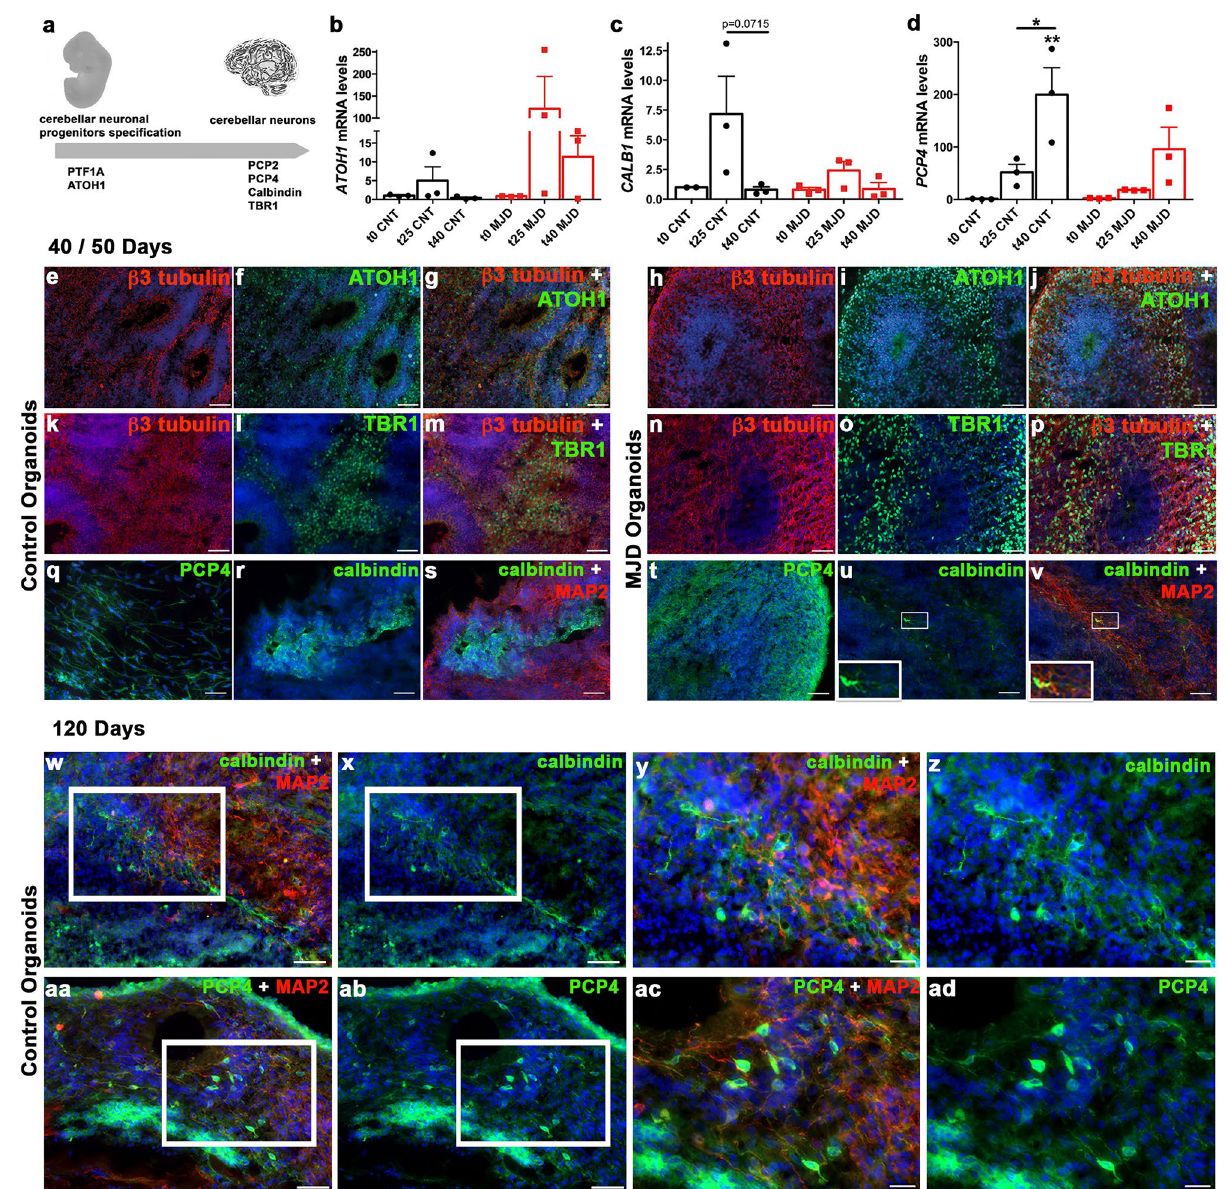
Figure 3. Control and MJD brain organoids present markers of cerebellar neurons. (a) Schematic representation of cerebellar neuronal progenitors (PTF1a and ATOH1) and cerebellar neurons (PCP2, PCP4, Calbindin, and TBR1) markers expression in cerebellum development. (b) ATOH1 , (c) CALB1 , and (d) PCP4 mRNA levels evaluation of Control (CNT) and MJD organoids, normalized for t0 CNT, collected at different time points (day 0, 25, and 40; t0, t25, and t40 respectively). Data indicated a significant enhancement of PCP4 mRNA levels at day 40. Data are expressed as mean ± SEM (n: 3 independent experiments), *p < 0.05 and **p < 0.01 (comparison established with the correspondent t0 or between the conditions indicated by the lines), One-way ANOVA followed by Tukey posttest. Immunohistochemistry evaluation of Control and MJD organoids with (e–v) 40/50 days and (w–ad) 120 days for the expression of markers of neurons (e,g,h,j,k,m,n,p) β3 tubulin and (s,v,w,y,aa,ac) MAP2, cerebellar neuronal progenitors (f,g,i,j) ATOH1, and of cerebellar neurons (l,m,o,p) TBR1, (q,t,aa–ad) PCP4, and (r,s,u,v,w–z) Calbindin; (u–v) lower insert: cell presenting Calbindin and MAP2 colocalization. ( y) magnification of the ( w ) image indicated in the white square; ( z) magnification of the ( x ) image indicated in the white square; ( ac) magnification of the ( aa ) image indicated in the white square; and ( ad) magnification of the ab image indicated in the white square. Data indicated the presence of cells positive for cerebellar neuronal progenitors and cerebellar neurons in control and MJD organoids. DAPI: blue, representative images of 3 ( e–v ) and 2 ( w–ad ) independent experiments, scale bars: 50 μm and ( y,z,ac,ad ) 20